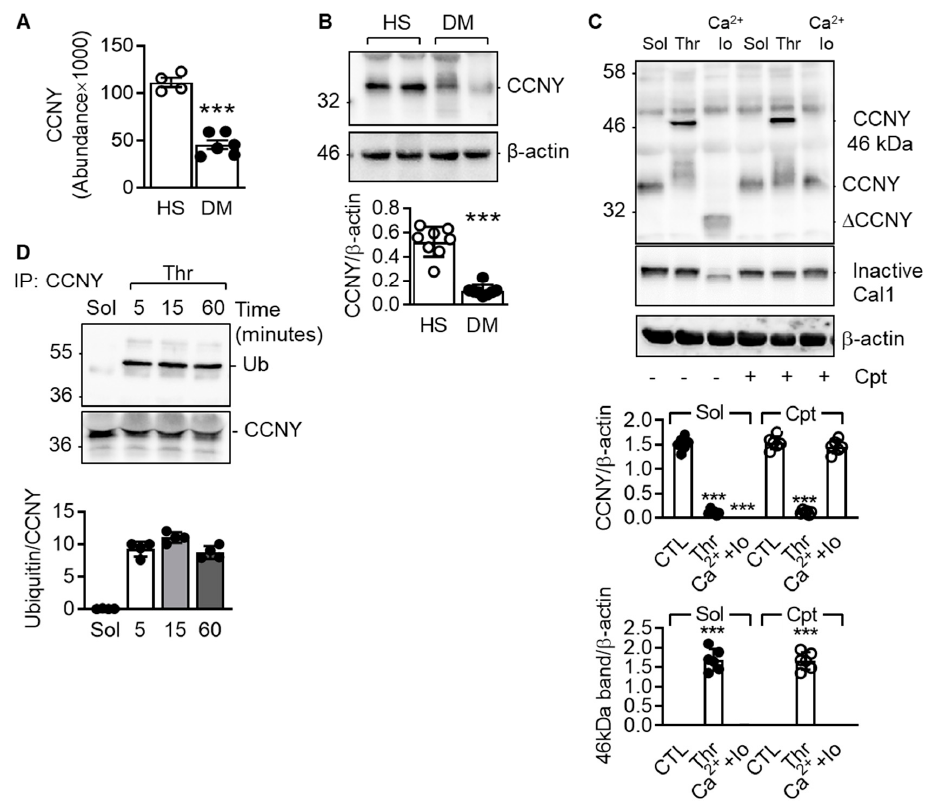
Figure 1. CCNY is expressed in human platelets and is monoubiquitinated upon platelet activation. ( A ) Graph showing levels of CCNY measured by mass spectrometry in platelets from healthy donors (HS) and from diabetic patients (DM); n = 4–6 (Student’s t test); ( B ) Blot showing the levels of CCNY in platelets from healthy donors (HS) and from diabetic patients (DM); n = 8 (Student’s t test); ( C ) Representative blots showing the e ff ect of thrombin (1 U / mL, 10 min) or Ca 2 + (5 mmol / L) and ionomycin (Io,1 µ mol / L), in the absence or in the presence of the calpain inhibitor calpeptin (cpt, 10 µ mol / L) on the levels of CCNY in washed human platelets; n = 6 (ANOVA and Newman-Keuls post-test); ( D ) CCNY was immunoprecipitated (IP) from platelets stimulated with either solvent (sol) or with thrombin (Thr, 1 U / mL) and immunoblotted with an antibody against ubiquitin (Ub) and CCNY; n = 4. *** p <